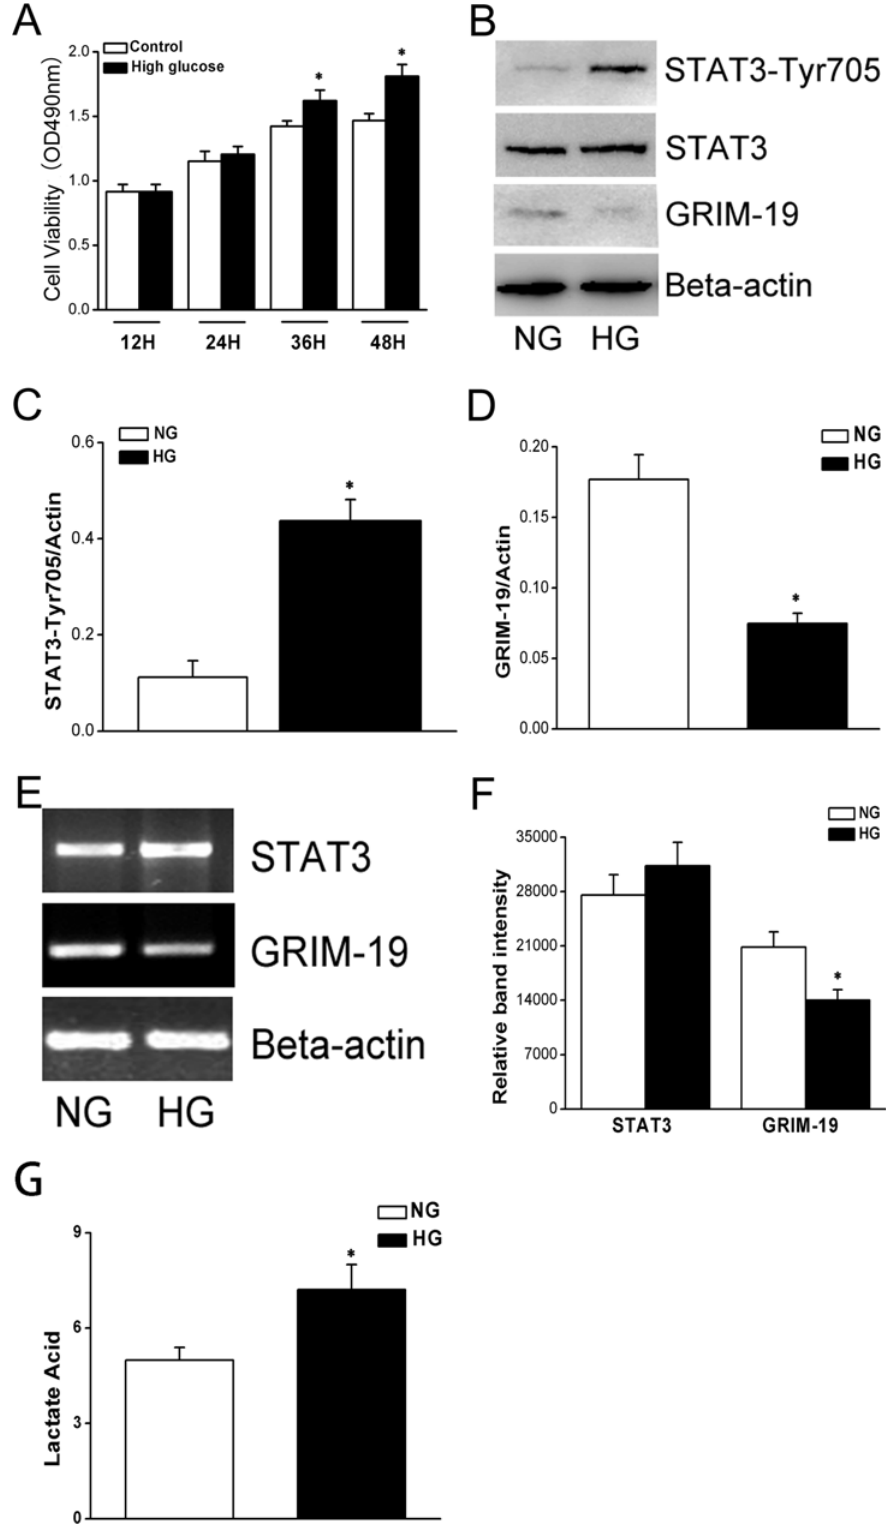
Fig 1. Time course changes in cell proliferation of HeLa cels in HG culture by MTT assay (shown in panel A). Both p-STAT3 over total STAT3 and GRIM-19 expression level were measured by western blotting (shown